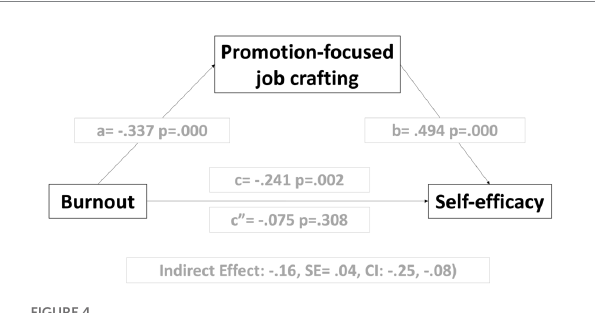
FIGURE 4 Results in mediation models of the promotion of job crafting on the influence of burnout on self-efficacy.